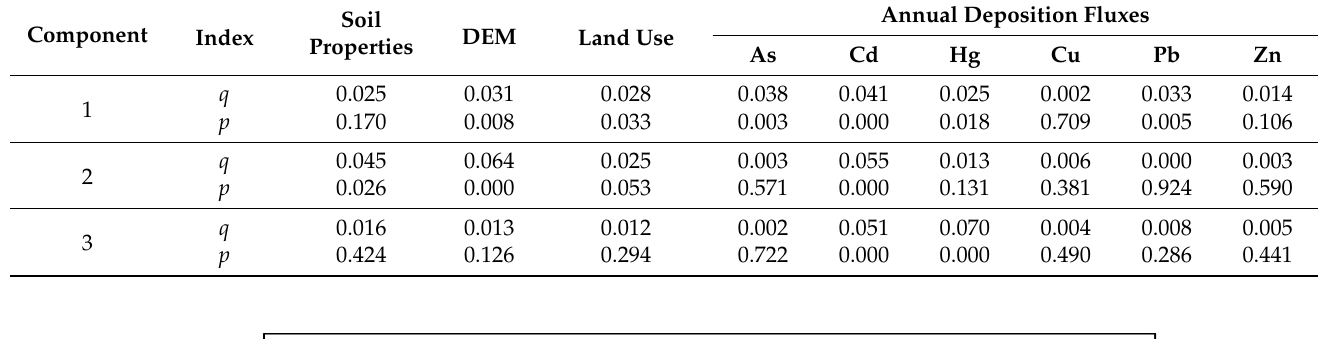
Table 4. The influencing factors on heavy metal concentrations at the multi-object level.